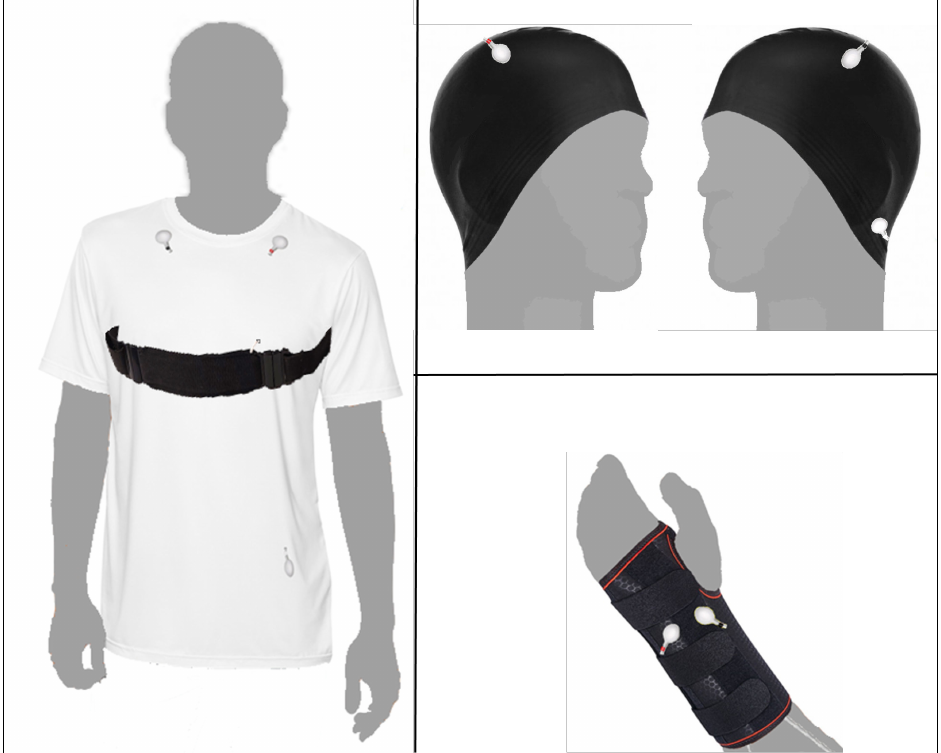
Figure 15. Proposal of integrated-sensor garment. Clockwise, starting from left: T-shirt with ECG and PZT sensors, integrated-EEG-sensor cap and wristband with integrated EDA